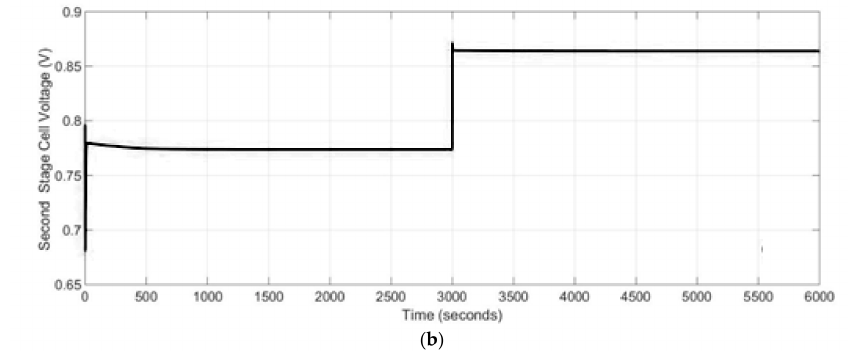
Figure 10. The cell voltage (V) for: ( a ) 1st stage SOFC stack, ( b ) 2nd stage SOFC stack.